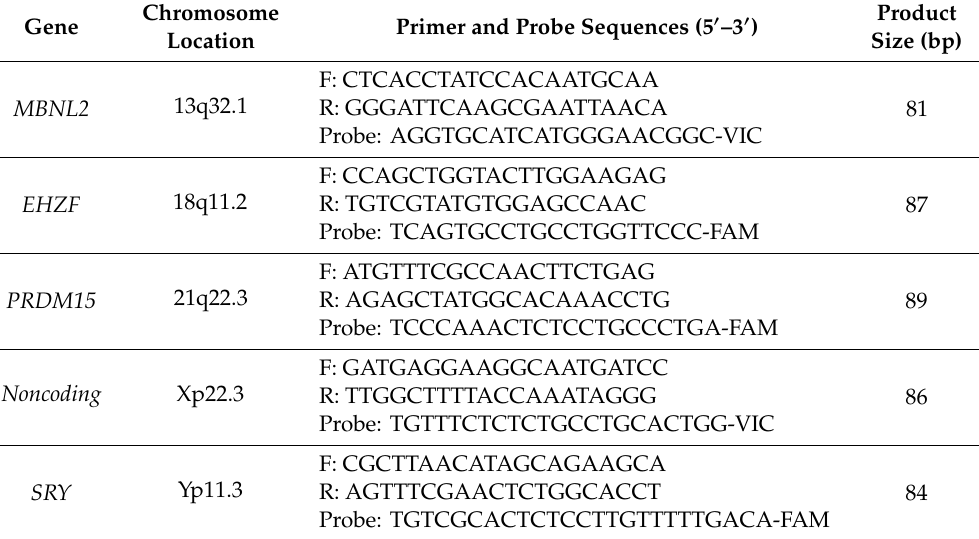
Table A1. Primer-probe assays. F, forward; R, reverse, VIC reporter dye-labeled probe with